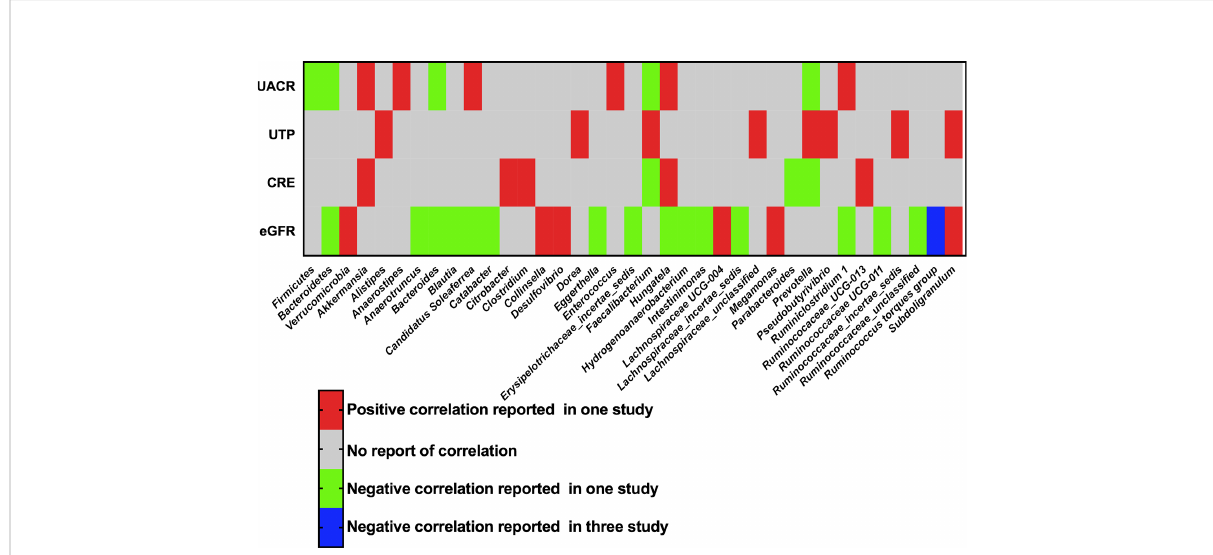
FIGURE 5 Correlation of gut microbiota and clinical parameters of DKD. UACR, urinary albumin-creatinine ratio; UTP, urinary total protein; CRE, creatinine; eGFR, estimated glomerular fi ltration